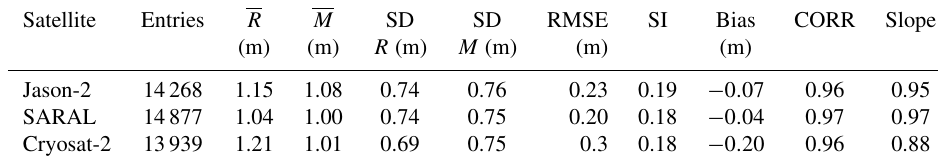
Table 3. Med-waves H s evaluation against satellite H s , for the full Mediterranean Sea, for a 1-year period (2014).